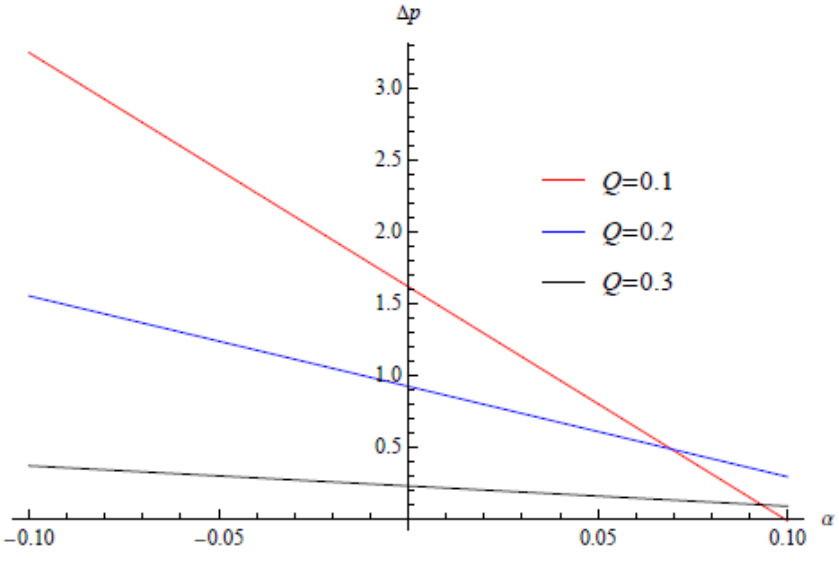
Fig. 8. Pressure rise vs. parameter of pseudoplasticity for various values of Q at 0 . 5  